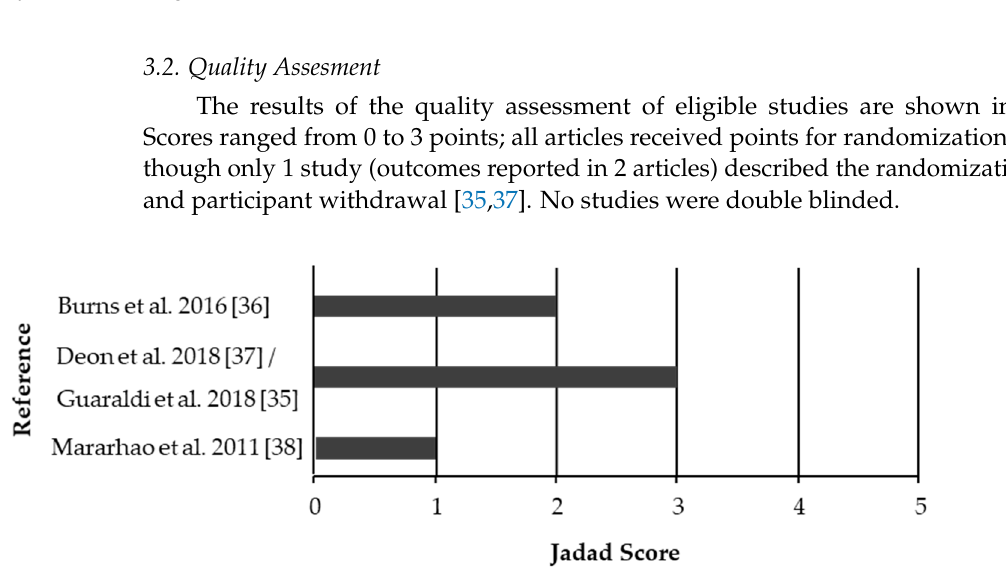
Figure 1. Flow diagram showing the screening process adapted from the Preferred Reporting Items for Systematic Reviews and Meta-Analyses (PRISMA) guidelines [32].